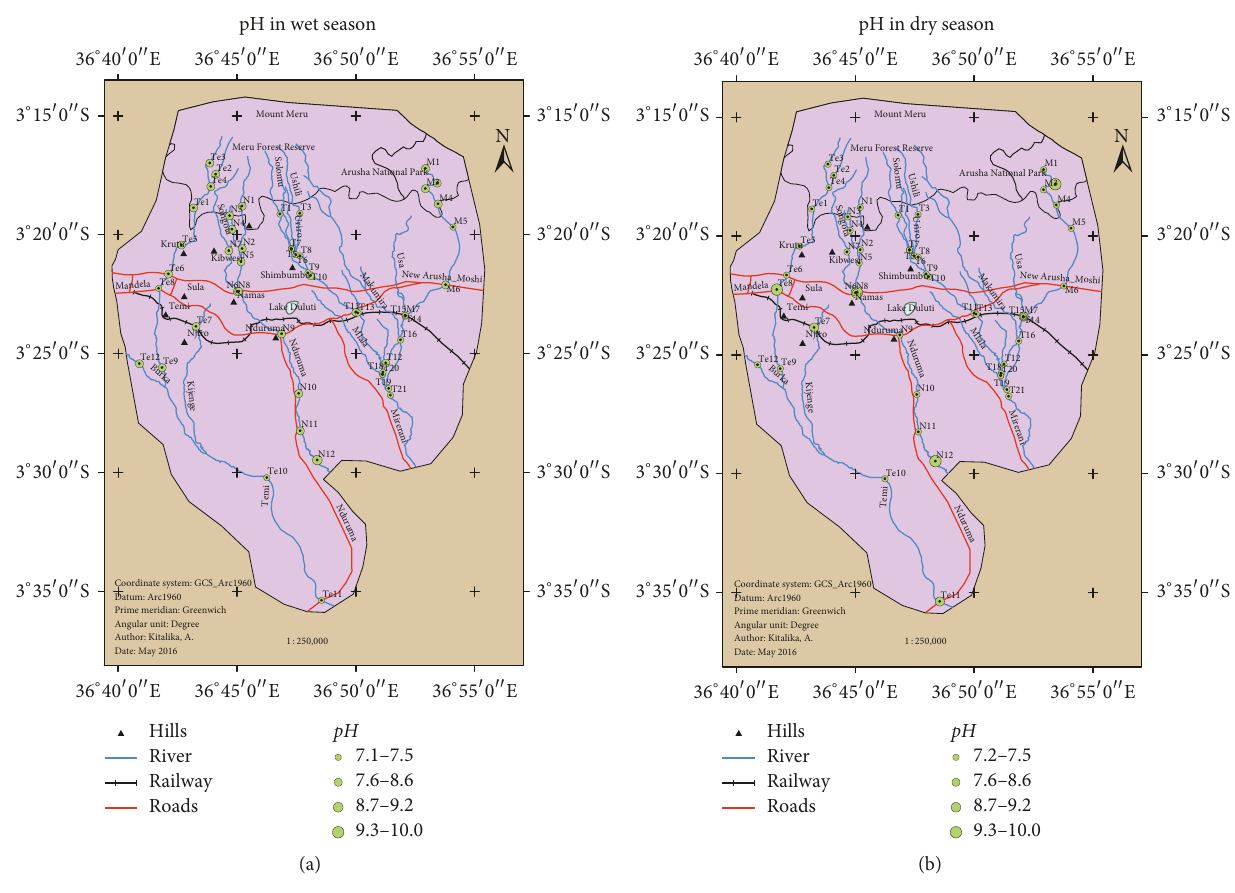
Figure 5: Water pH in wet (a) and dry (b)